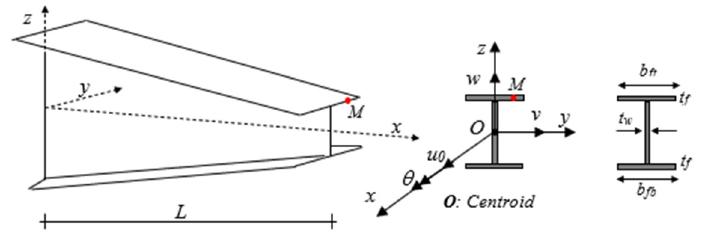
Figure 1. Geometrical scheme of variable doubly symmetric I-section beam—coordinate system and notation for the displacement parameters.